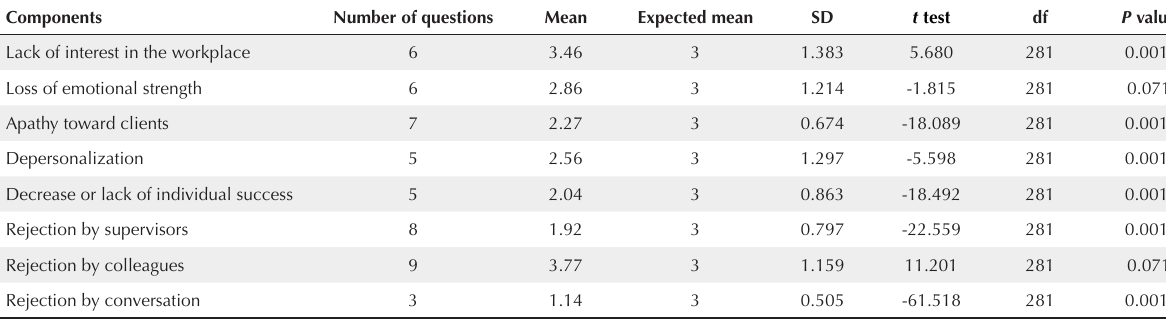
Table 1. One sample t test results of emotional exhaustion and workplace ostracism Components